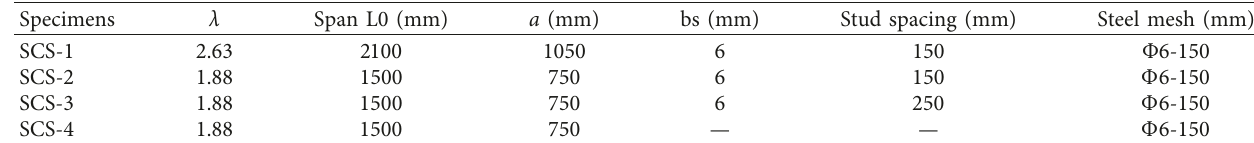
Figure 2: Sectional dimensions of specimens. Table 1: Test matrix of steel plate-concrete composite deep